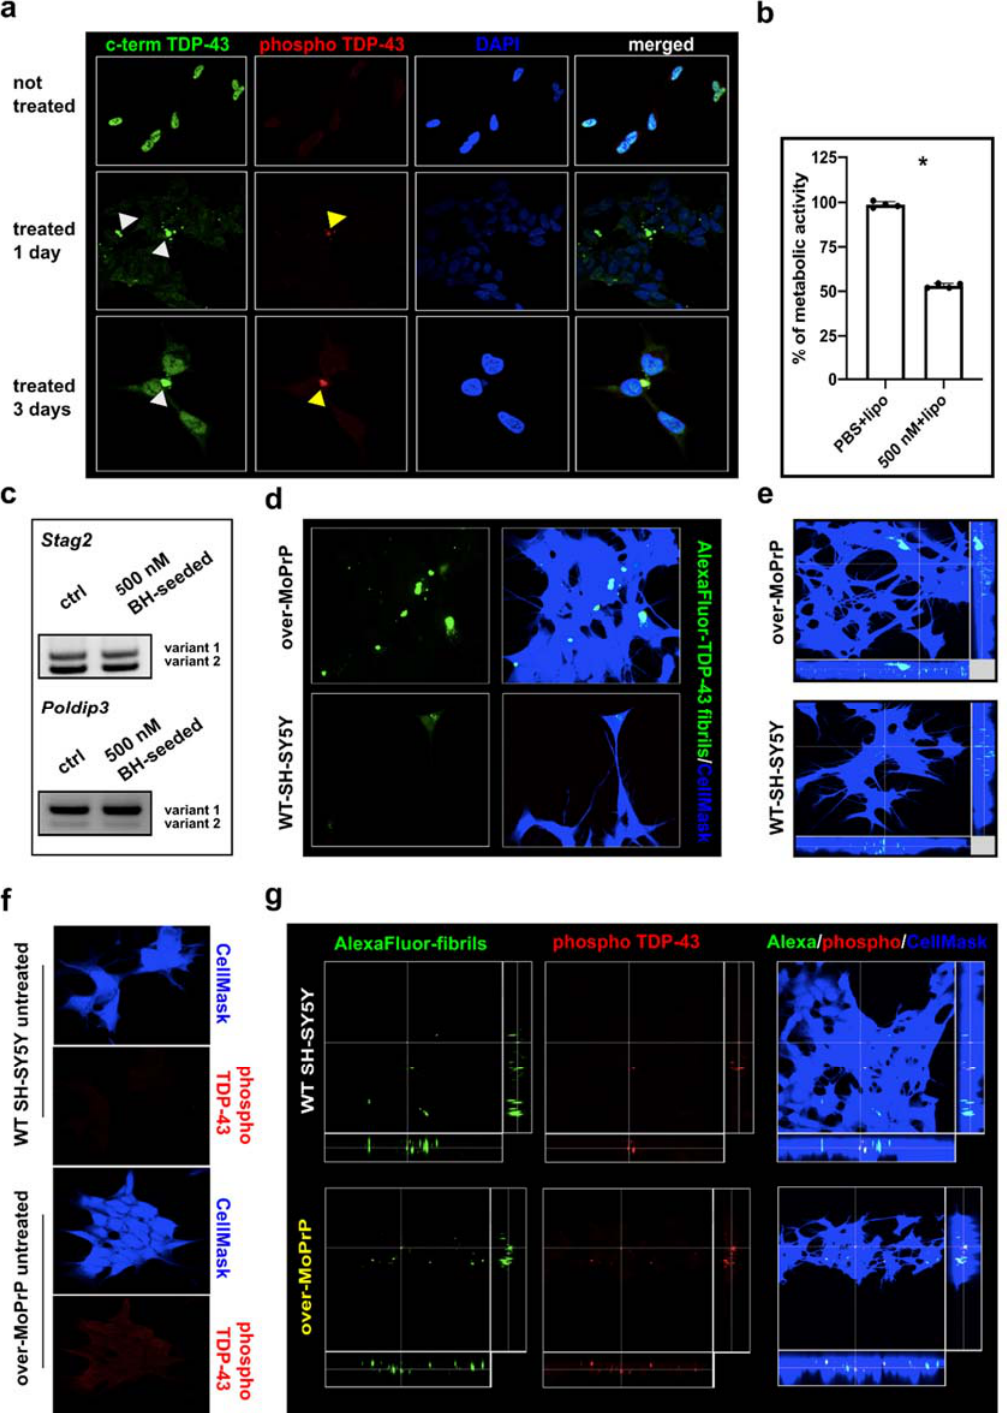
Figure 3. Internalization and phosphorylation of TDP-43 fibrils in WT and over-MoPrP SH-SY5Y cells ( a ) Representative immunofluorescence images of WT-SHSY5Y cells untreated and treated with 500 nM BH-seeded TDP-43 LCD sonicated fibrils mixed with lipofectamine to force their entrance within cells. Cells at 1 or 3 days post-treatment show the presence of green-fluorescent TDP-43 positive aggregates stained with the rabbit polyclonal anti-TDP-43 C-terminal antibody (white arrowheads). Several TDP-43 positive aggregates are recognized also by the anti-phospho TDP-43 (Ser409/Ser410) antibody (yellow arrowheads); ( b ) treatment with fibrils resulted in a reduction of cell vitality evaluated with the MTT assay. Cell vitality was evaluated as the percentage of treated cells with an active metabolism at the MTT assay compared to control